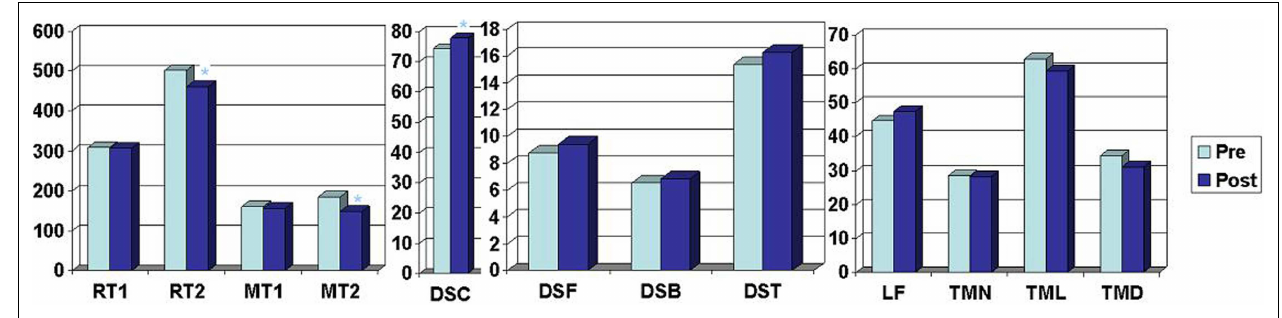
forward; DSB, digit span backward; DST, digit span total; LF, letter fluency;TMN, trail making numbers;TML, trail making letters;TMD, trail making